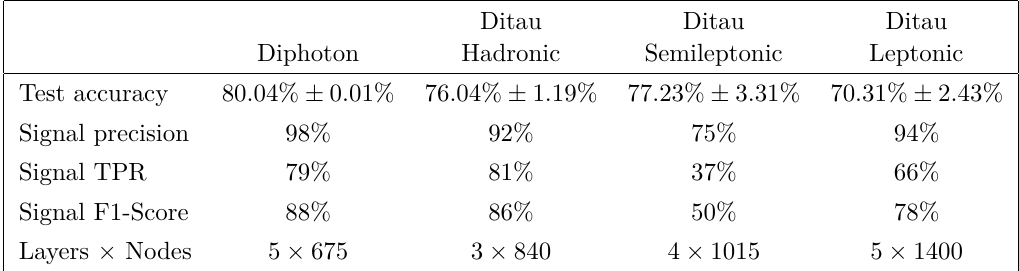
Table 7 . Results for NN classification presented. Table shows the statistics of the NN calculated for the test sample. Last row of the table shows the number of hidden layers and node per each layer.